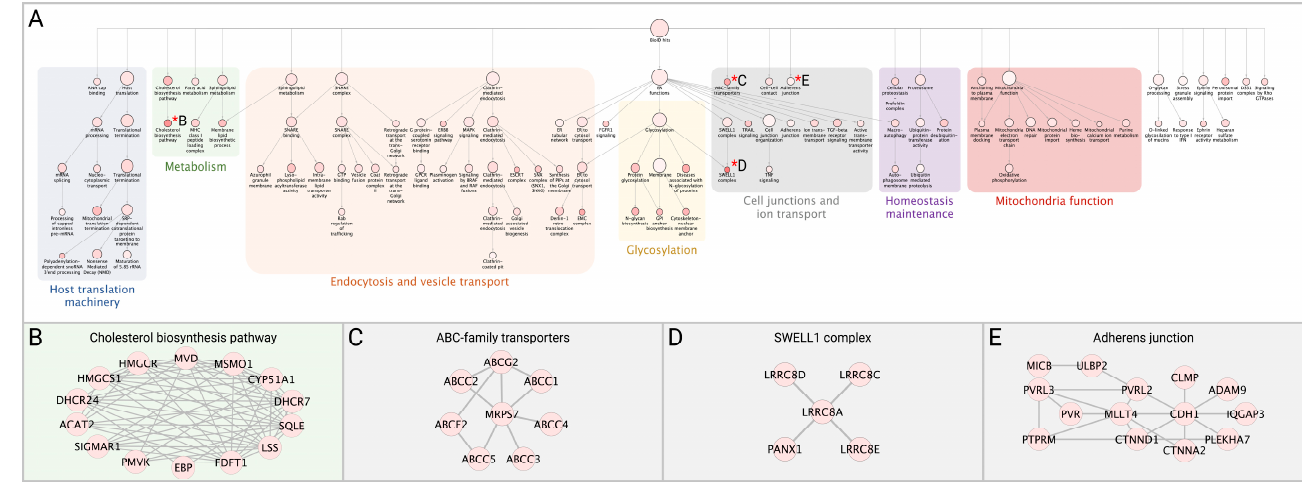
Figure 4. Network analysis of SARS-CoV-2 interactors. ( A ) The network containing the 876 identified SARS-CoV-2 interactors was subjected to supervised community detection, and the resulting hierarchy is shown. Each node represents a cluster of interconnected proteins and each edge (marked by an arrow) represents containment of one community (target) by another (source). Indicated are enriched biological processes as determined by gProfiler. ( B – E ) Asterisks (*) denote selected zoom-in insets from the hierarchy. Nodes represent human proteins, and edges are interactions from STRING.